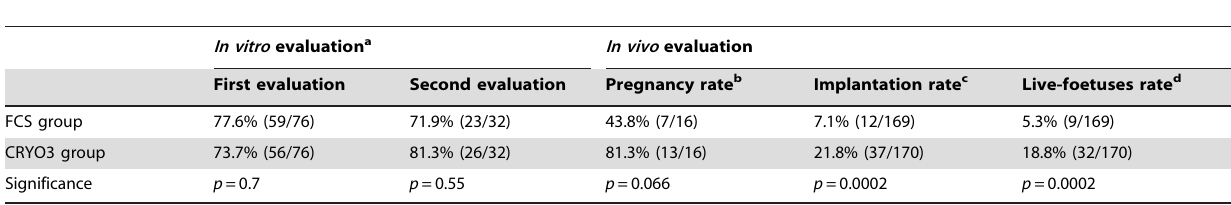
Table 2. Embryo viability after in vitro and in vivo